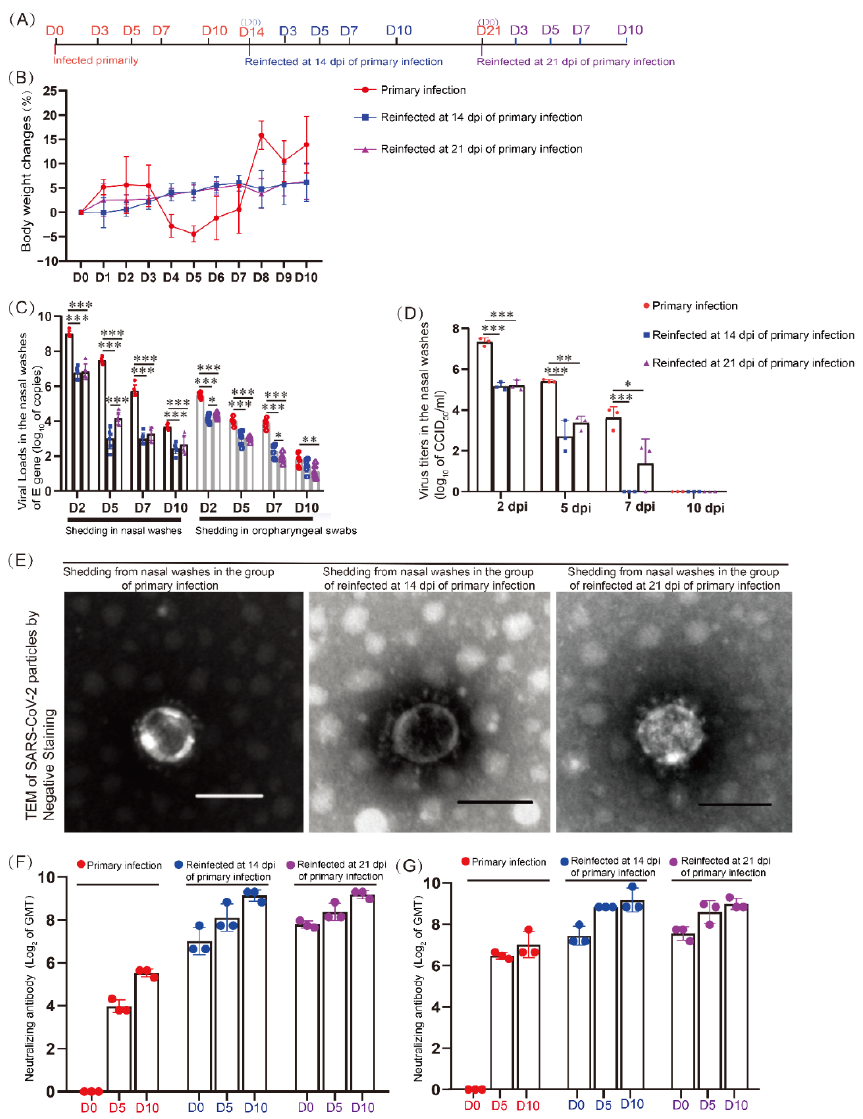
Figure 1. Specific neutralizing antibodies were promoted during reinfection but could not control SARS-CoV-2 shedding from the upper respiratory tract. ( A ) Experimental progress chart. This project included three groups that were infected primarily and infected secondarily at 14 dpi and 21